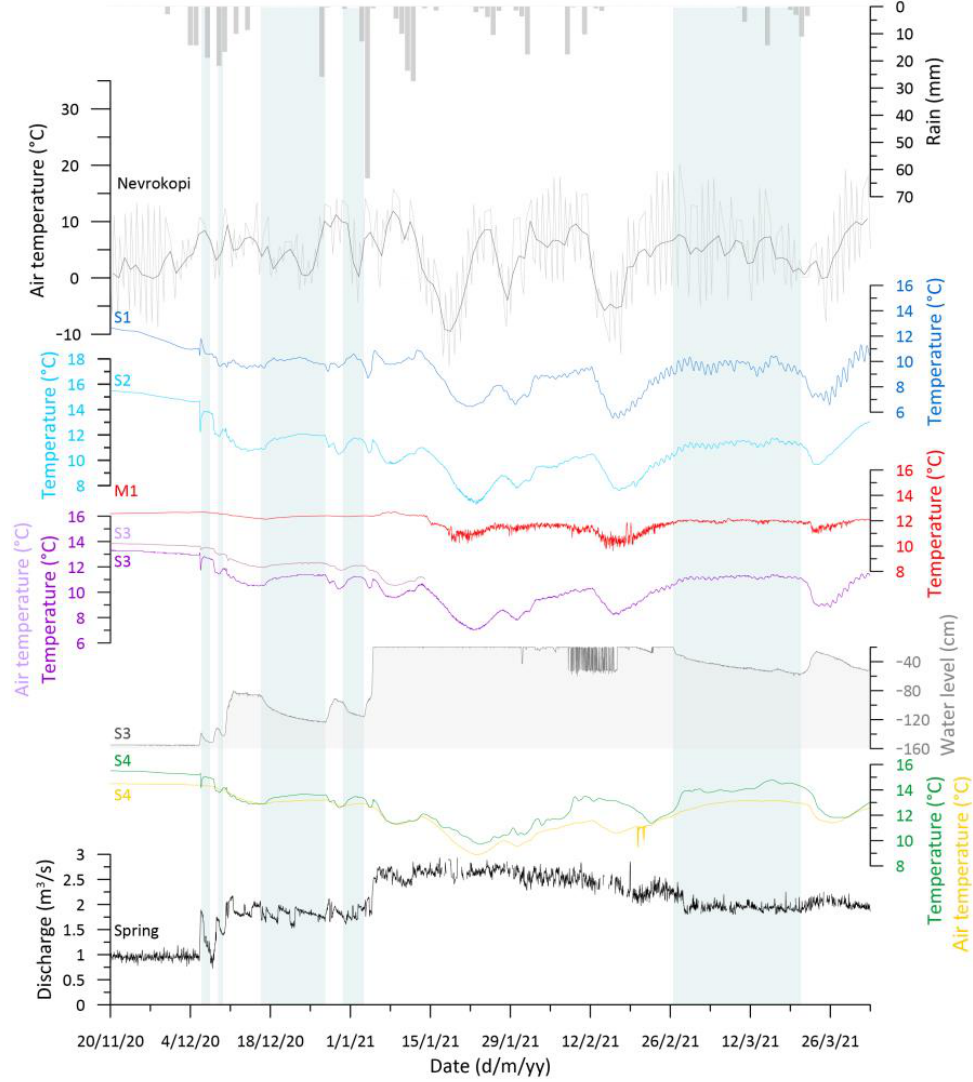
Figure 5. November 2020 to April 2021 recordings. Blue vertical bars indicate recession periods based on water level at station S3.